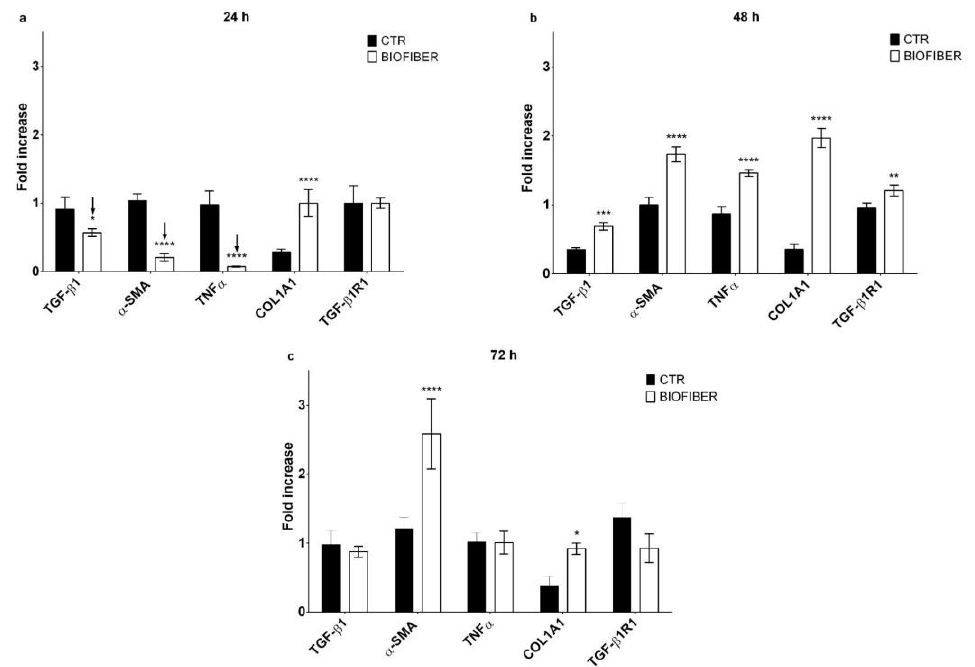
Figure 12. Gene expression analysis of HSF treated with Biofiber for 24, 48 and 72 h. ( a ) qRT-PCR at 24 h. ( b ) qRT-PCR at 48 h. ( c ) qRT-PCR at 72 h. Results are normalized to the housekeeping gene (Glyceraldehyde-3-Phosphate Dehydrogenase (GAPDH)). Statistically significant values are indicated as * p < 0.05, ** p < 0.01, *** p < 0.001, **** p < 0.0001. Analysis of variance test was performed to evaluate data significance.